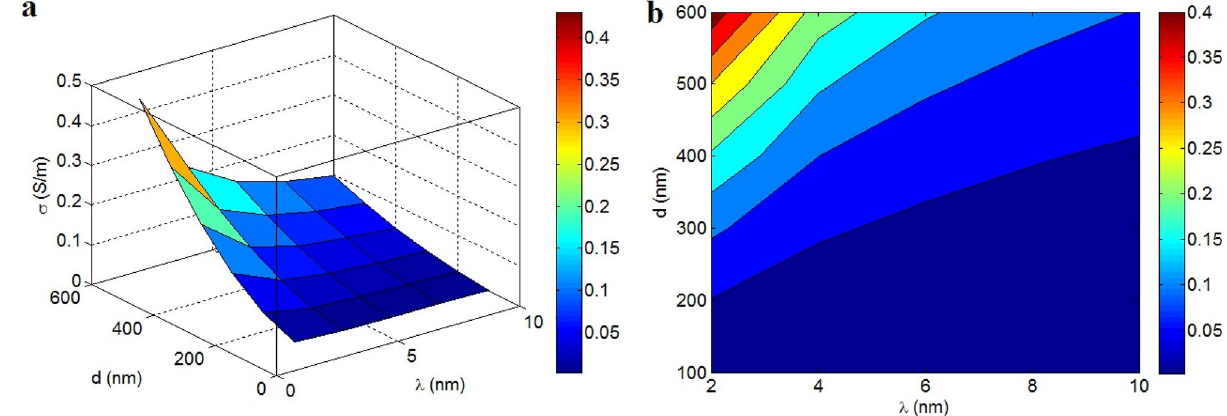
Figure 8. Expression of efficient conductivity at various points of “λ” and “d” by ( a ) 3D and ( b ) contour patterns.